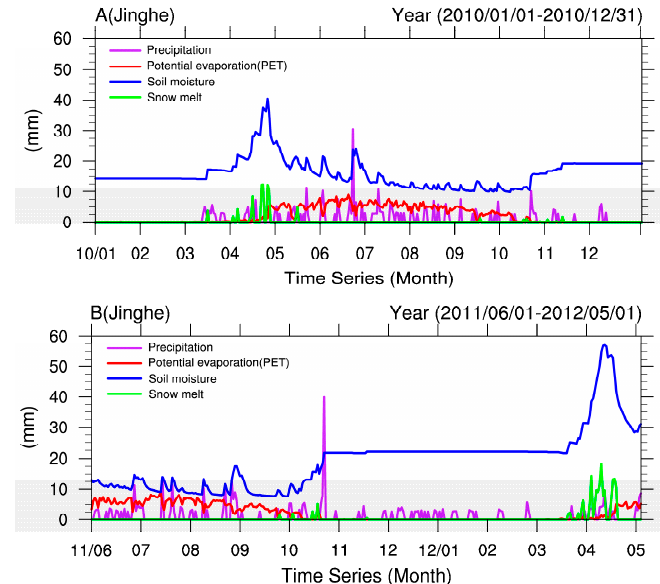
Figure 14. Time series of the soil moisture and precipitation in the JBR (Take the Jinghe Mountain station as an example).